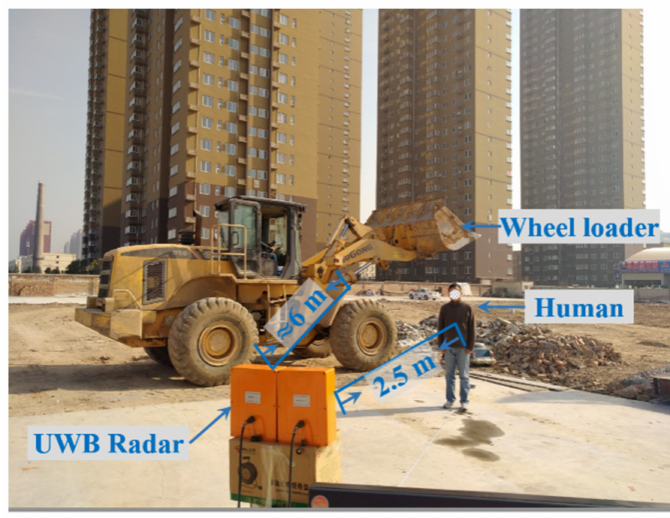
Figure 5. Experimental